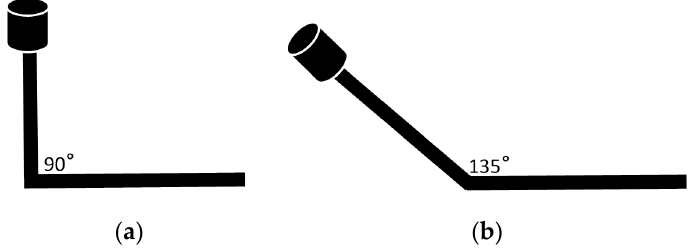
Figure 1. Different vertical orientations of the laser scanner. Practically, an angle of 130–140 degrees provides a good data coverage for typical urban environments.